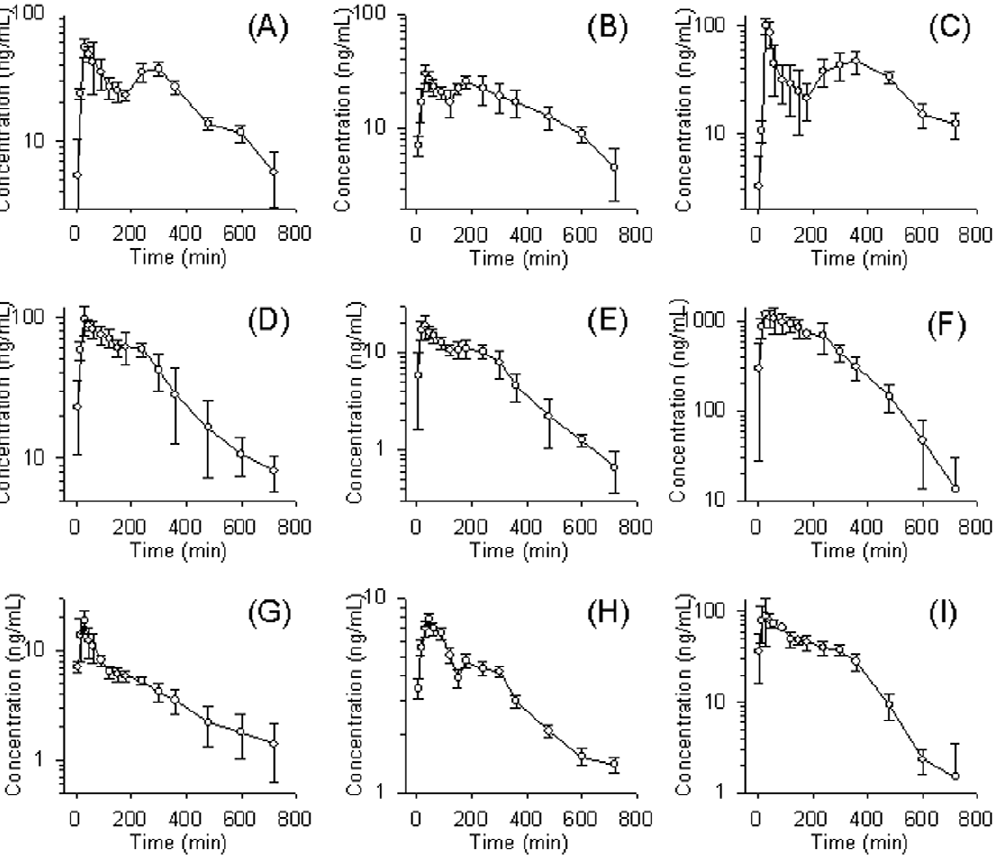
Figure 3. Mean plasma concentration–time profile in rat plasma after oral administration of bu-yang-huan-wu-tang extract for astragaloside I (A), astragaloside II (B), astragaloside IV (C), formononetin (D), ononin (E), calycosin (F), calycosin-7-O- b -D-glucoside (G), ligustilide (H) and paeoniflorin (I).